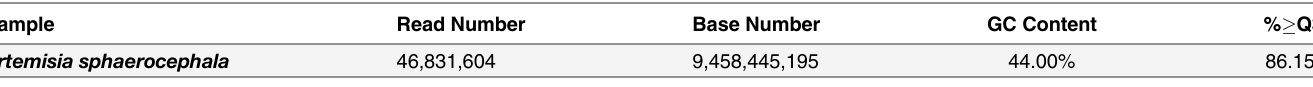
Table 1. Summary of transcriptome sequencing results.